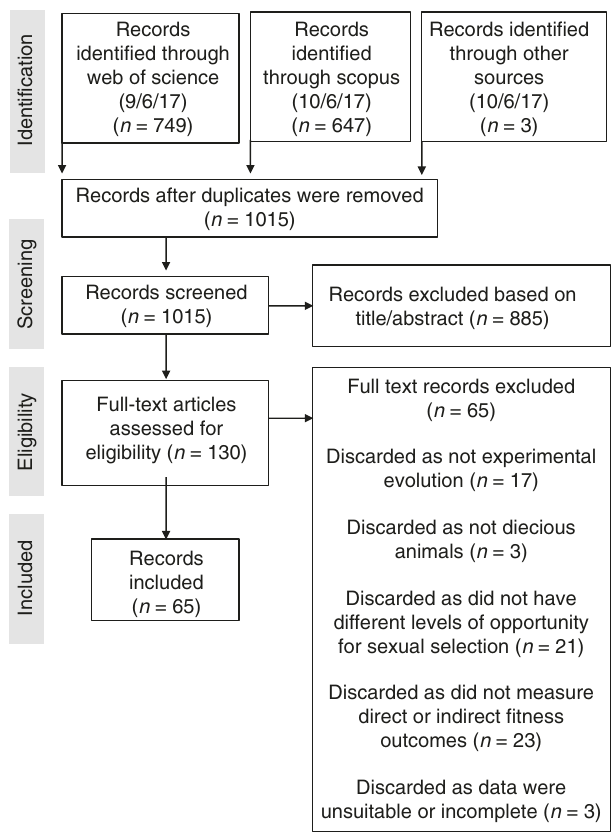
Fig. 4 PRISMA diagram. Flow of inclusion and exclusion of studies identi fi ed during the literature search, presented as a PRISMA diagram with number of published papers in